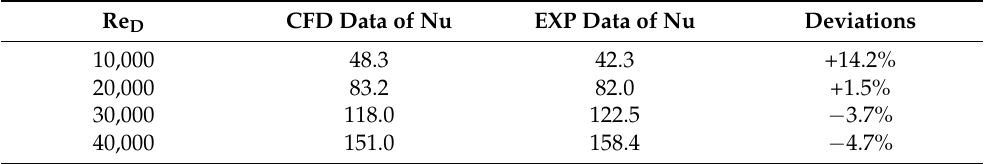
Figure 5. Validation between the current computed data and the experimental measured data from Rao et al. [15] for the smooth tube with five jets: ( a ) Circumferentially averaged Nusselt number at Re D = 40,000; ( b ) Local Nusselt number distributions at Re D = 10,000 and Re D = 40,000. Table 2. Comparisons of the area-averaged Nusselt number between the current computed data and the experimental measured data from Rao et al. [15] for a smooth tube with five